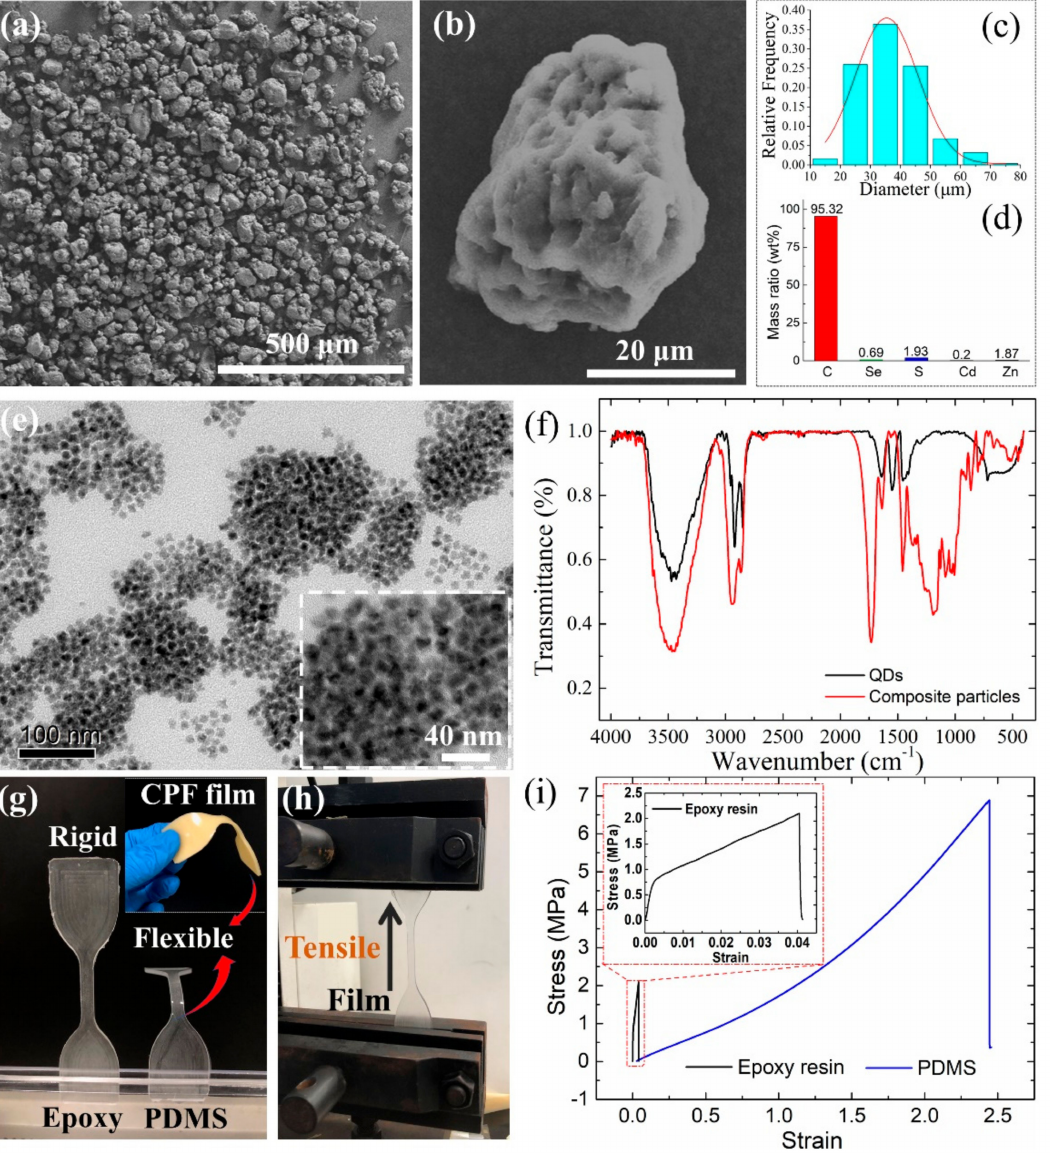
Figure 2. ( a ) SEM of composite particles. ( b ) Element mapping images of the composite particle. ( c ) Diameter distribution. ( d ) Element mass ratio distribution of corresponding mapping particle. ( e ) HRTEM images of QDs in epoxy resin. ( f ) FTIR spectra of QDs and composite particles. ( g ) Flexibility of PDMS film and rigidity of epoxy film. The inset shows the flexibility exhibition of CPF film. ( h ) Stress-strain curves measurement process. ( i ) Stress-strain curves of PDMS and epoxy films obtained from tensile